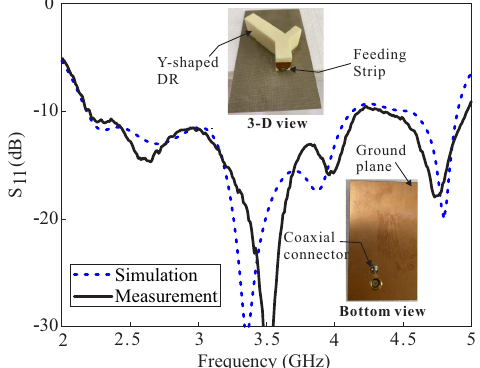
Figure 8. Comparative simulated and measured reflection coefficients of the proposed DRA.